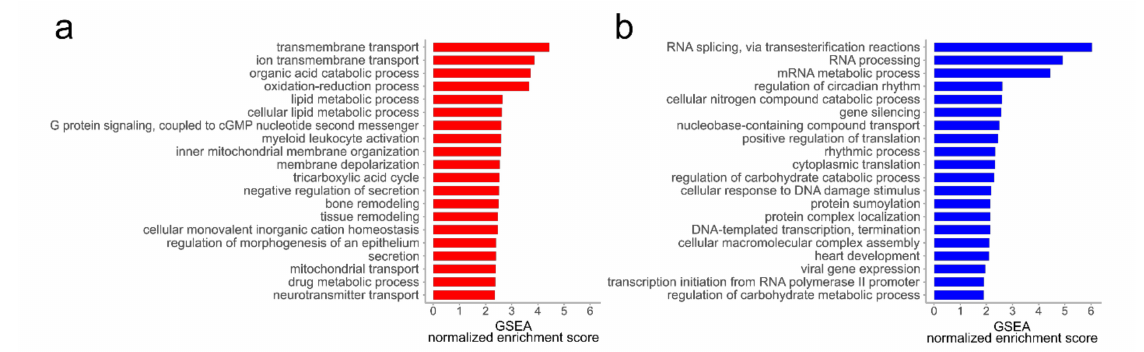
Figure 7. The 20 most significant gene set hits of MKTPC proteomes from older vs. young individual donors. SignificantGeneSetEnrichmentAnalysis(GSEA)results(FDRq-value < 0.05)weresummarized by reducing redundancy with REVIGO. Only gene sets from the GO biological process category were utilized. Gene sets enriched in the MKTPC proteome of old donors ( a ) and enriched gene sets in the MKTPC proteome of young donors ( b ) are